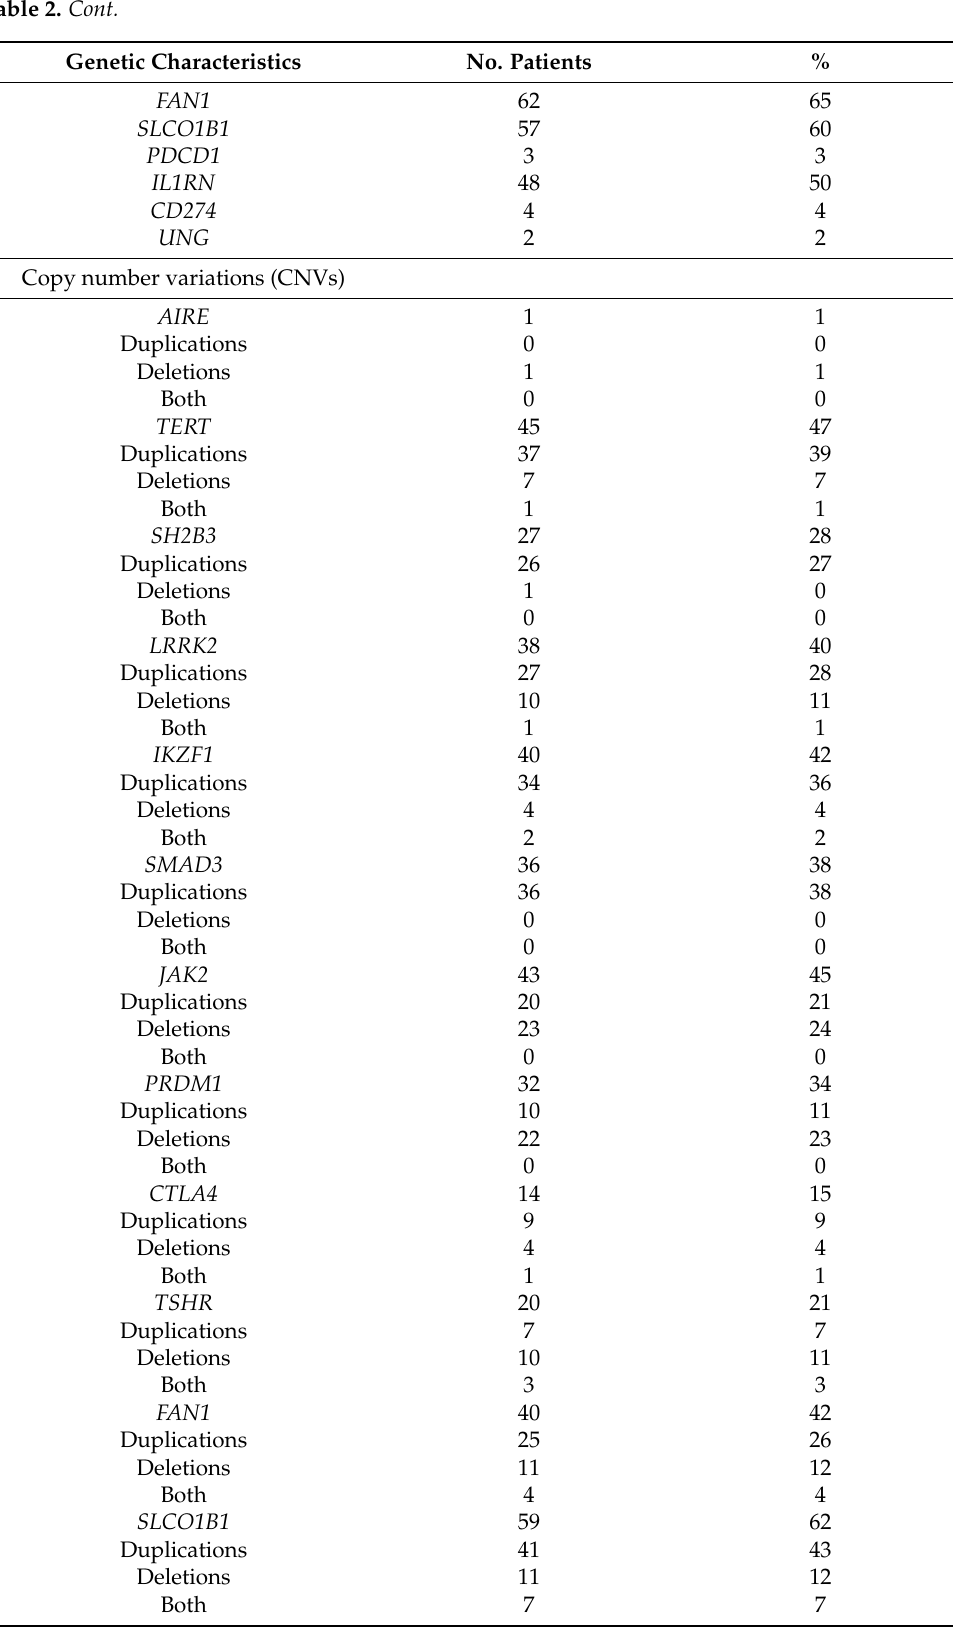
Table 2. Cont. Genetic